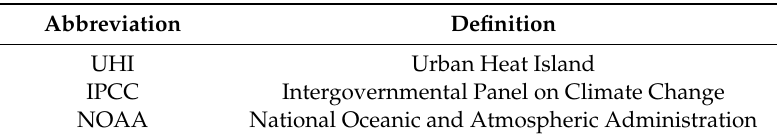
Table 1. Nomenclature of main terms